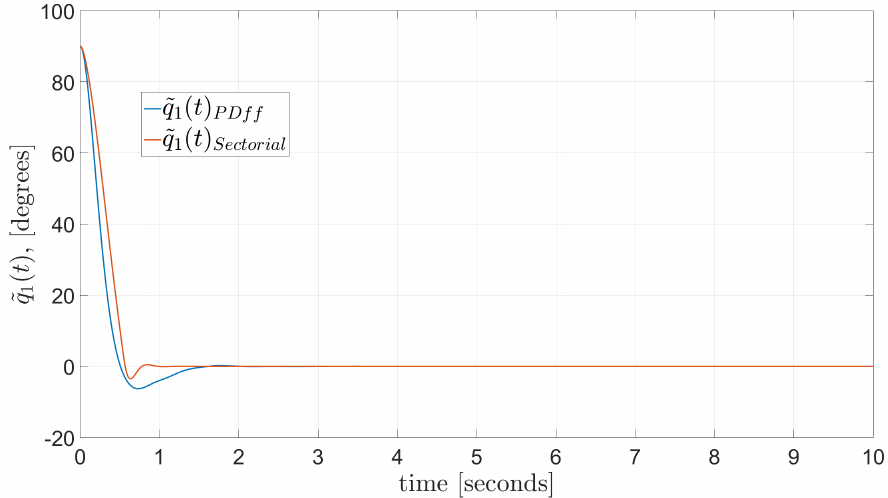
Figure 15. Angular Position error for joint 1, without Coulomb friction.